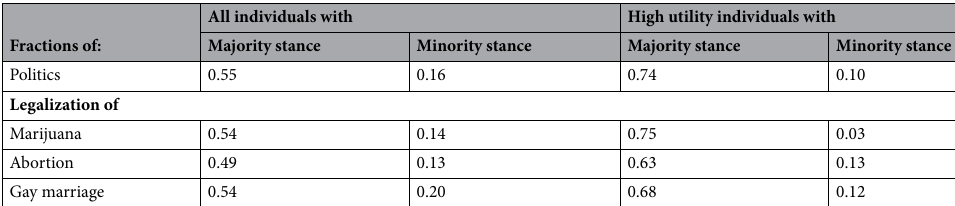
Table 3. Majority and minority stance analysis. A comparison between stance popularity for fractions of nodes with majority and minority stances among all members and among the top 10% of members with the highest